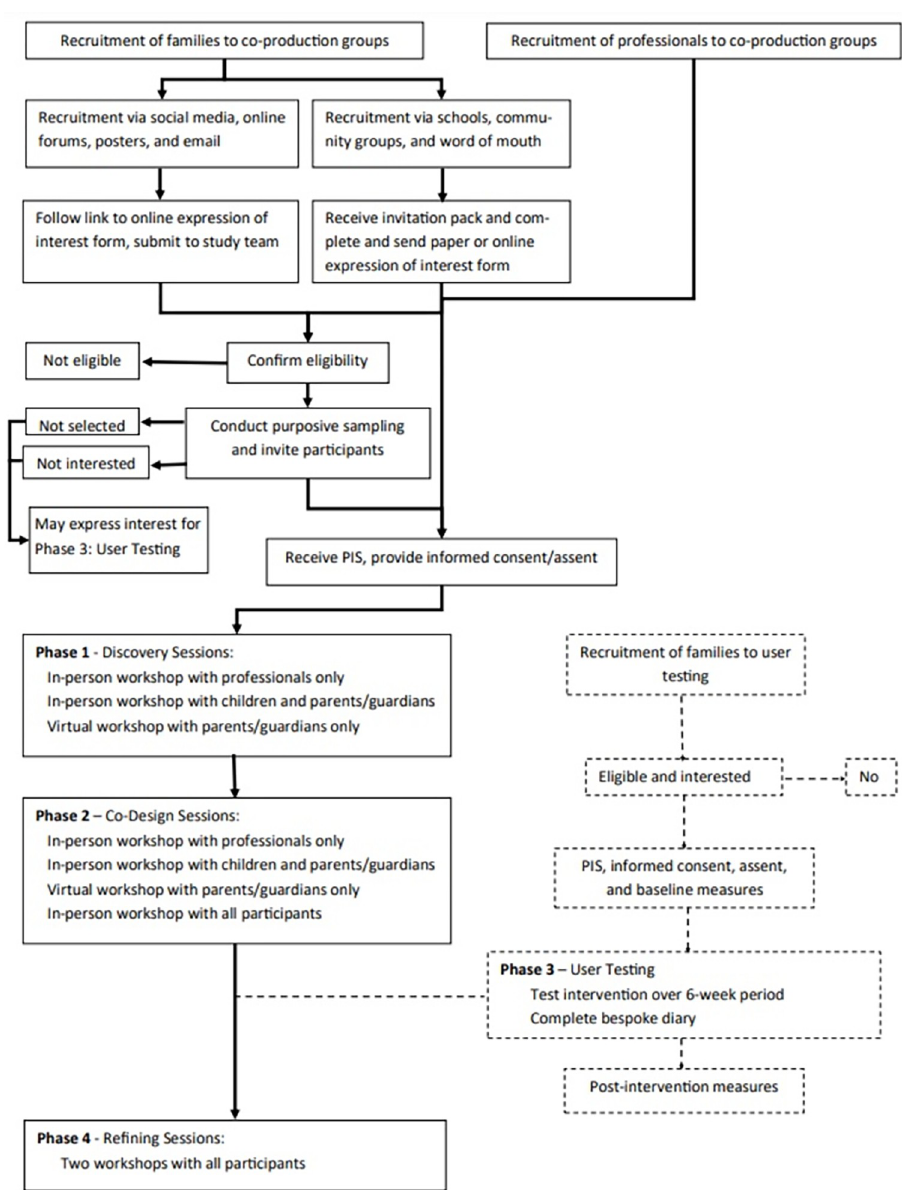
Fig 1. Flow diagram of study components and phases. PIS: Participant information